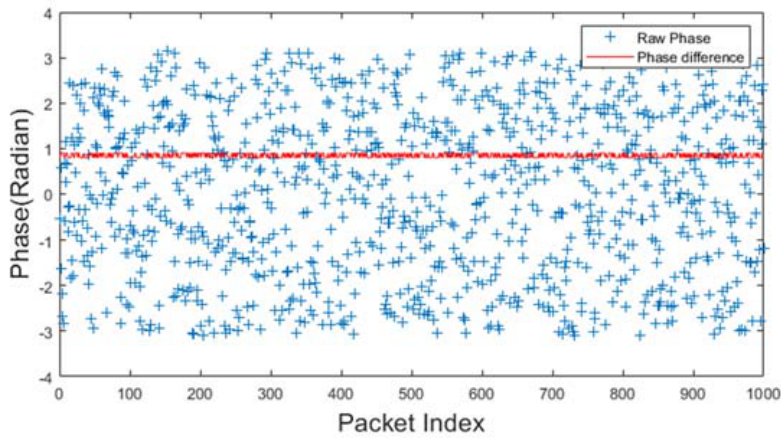
Figure 4. Phase difference distribution. Figure 4. Phase di ff erence